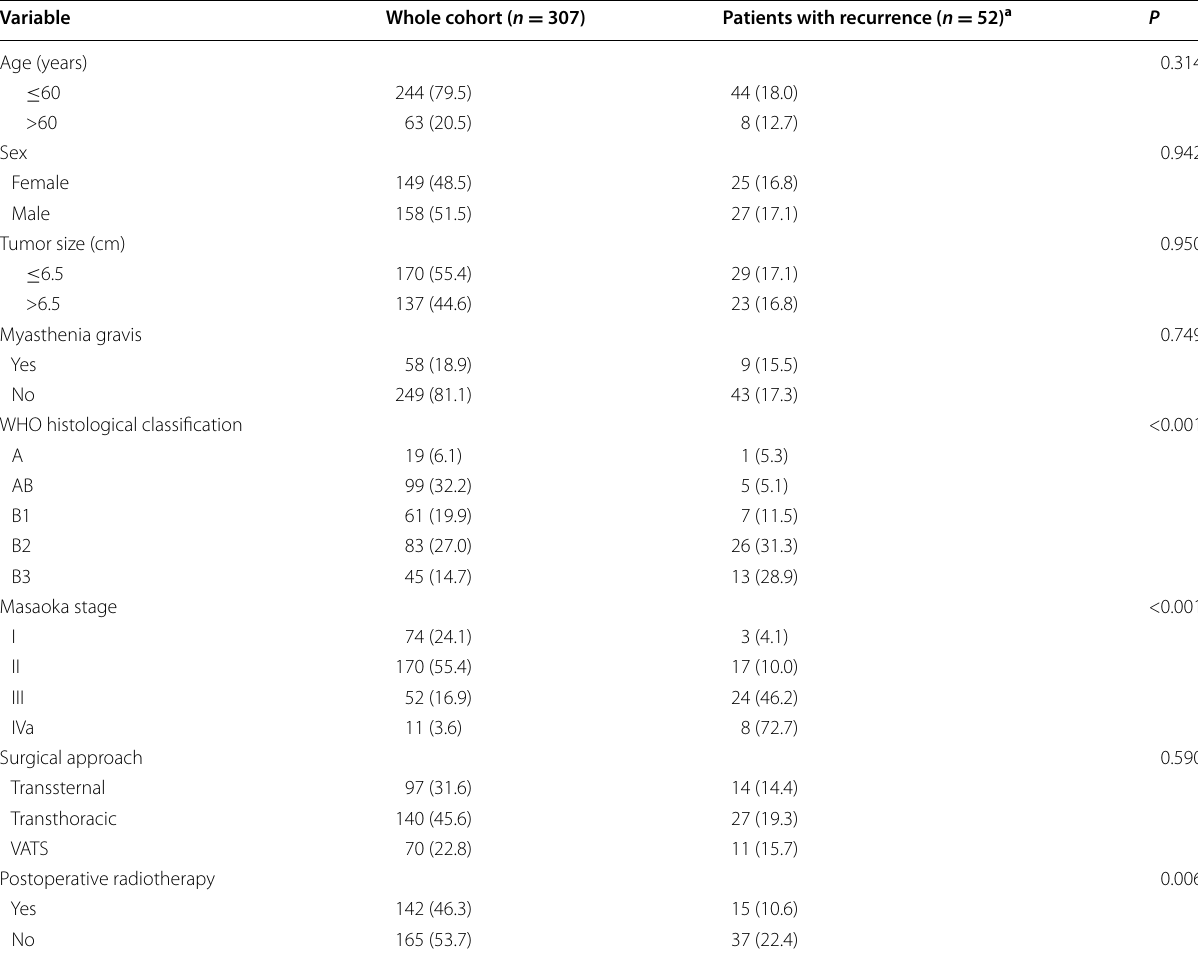
Table 1 Characteristics of 307 patients with primary thymoma and their association with recurrence